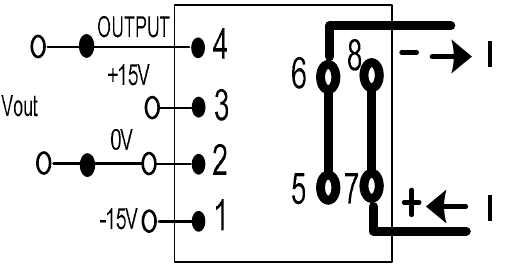
Figure 2. The current signal sensors by LEN-HX-10NP [23].